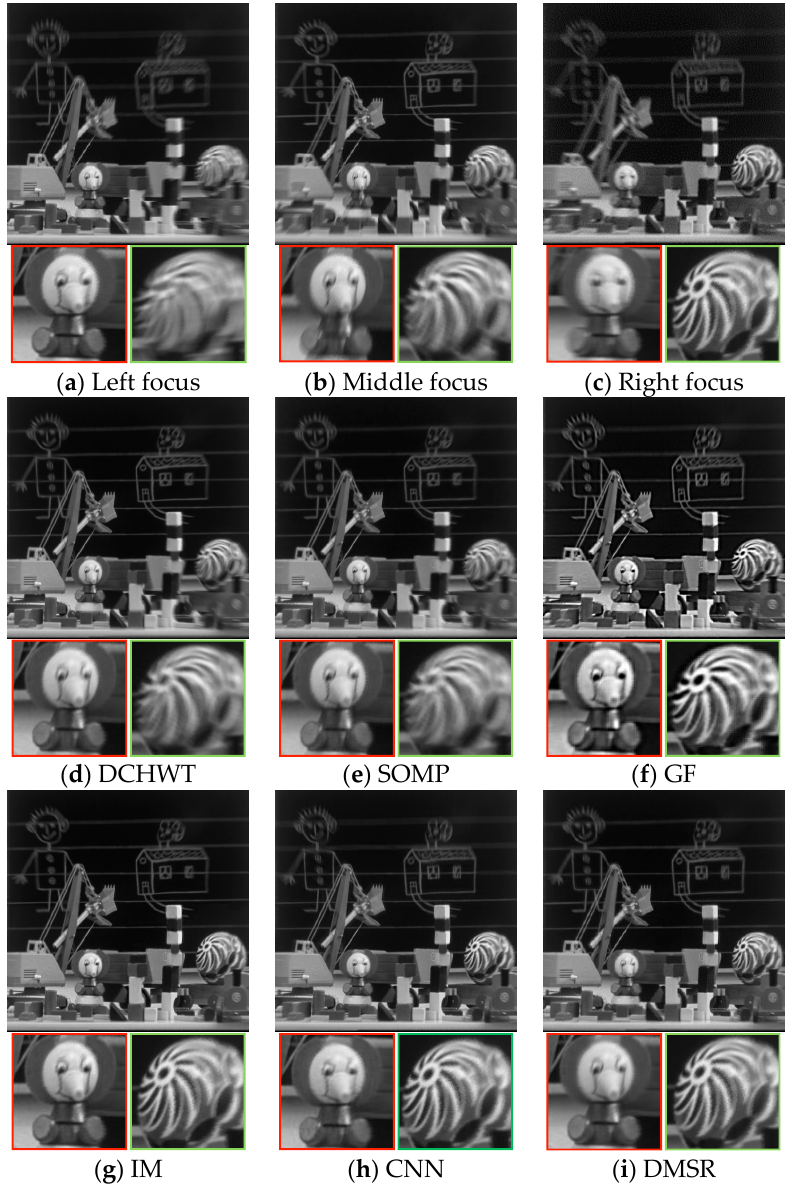
Figure 14. The three multi-focus image and fusion results obtained by different fusion methods.